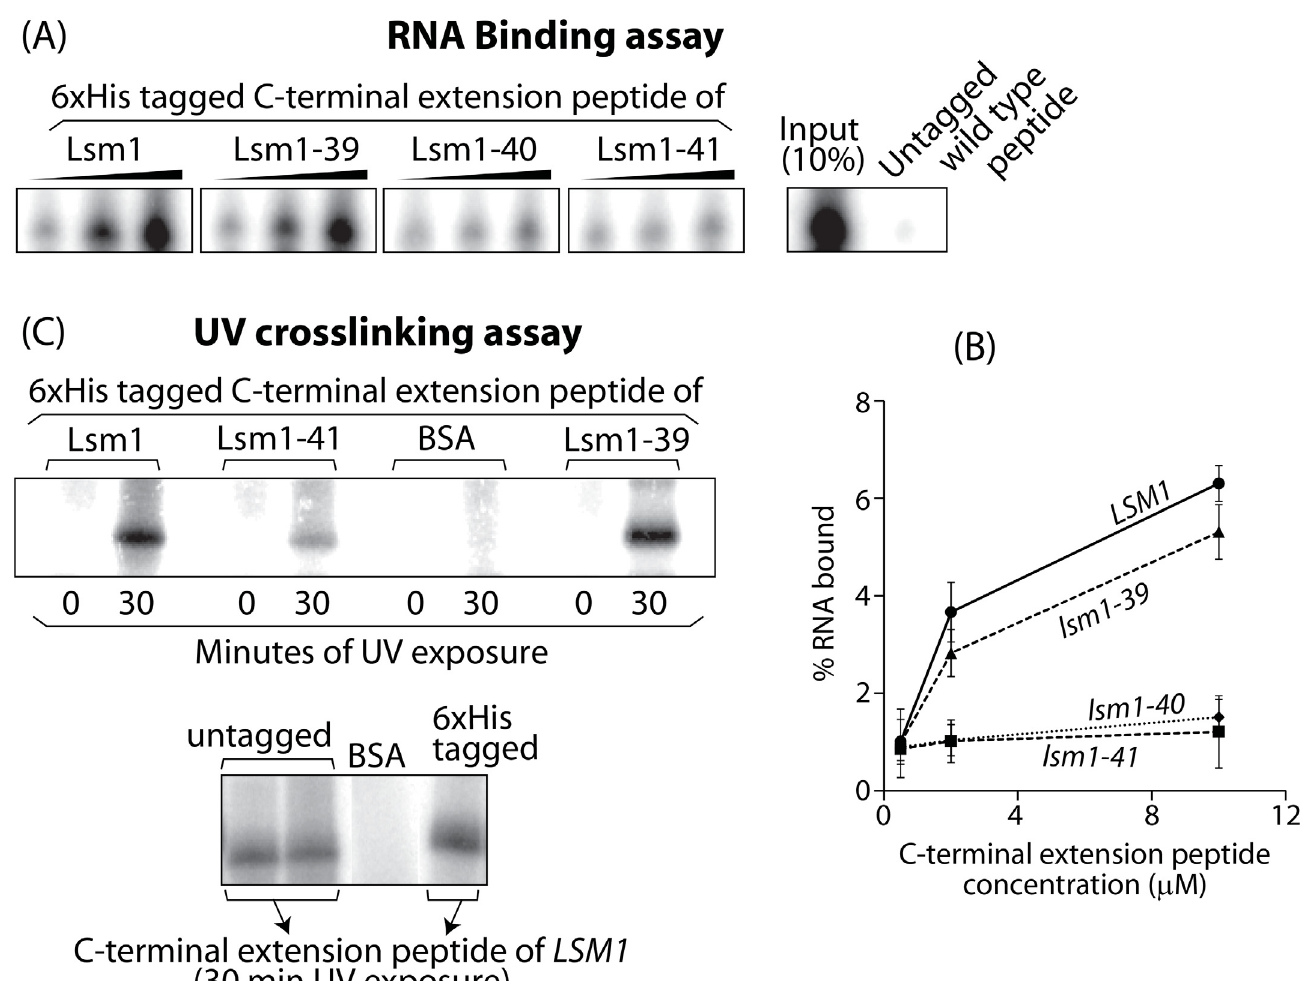
Fig 5. The C-terminal extension of Lsm1 is able to bind RNA by itself and the C-terminal most 8 residues are important for such binding. A , Synthetic untagged wild type Lsm1 C-terminal extension peptide (10 μ M) or increasing concentrations (0.5 μ M, 2 μ M and 10 μ M) of synthetic 6xHis- tagged C-terminal extension peptides corresponding to LSM1 , lsm1-39 , lsm1-40 or lsm1-41 were incubated with radiolabeled in vitro transcript carrying the 3 ’ -most 43 residues of the yeast MFA2 mRNA and then subjected to pull down using the Ni-NTA matrix. After washing, the co-precipitated RNA was run alongside untreated RNA (10% of total amount used for the binding) and then visualized by denaturing PAGE and phosphorimaging. B , A plot of the percentage of RNA bound vs the concentration of the peptide used is shown. Plotted values are mean ± SD from three independent trials. C , Top panel , bovine serum albumin (BSA) or synthetic C-terminal segment peptides (2 nmols each) corresponding to LSM1 , lsm1-39 or lsm1-41 were incubated with radiolabeled in vitro transcript carrying the 3 ’ -most 43 residues of the yeast PGK1 mRNA, UV crosslinked, treated with ribonuclease and then visualized by SDS-PAGE and phosphorimaging. Bottom panel , Similar UV crosslinking analysis carried out with synthetic wild type Lsm1 C- terminal extension peptide (untagged or 6xHis-tagged) or BSA is